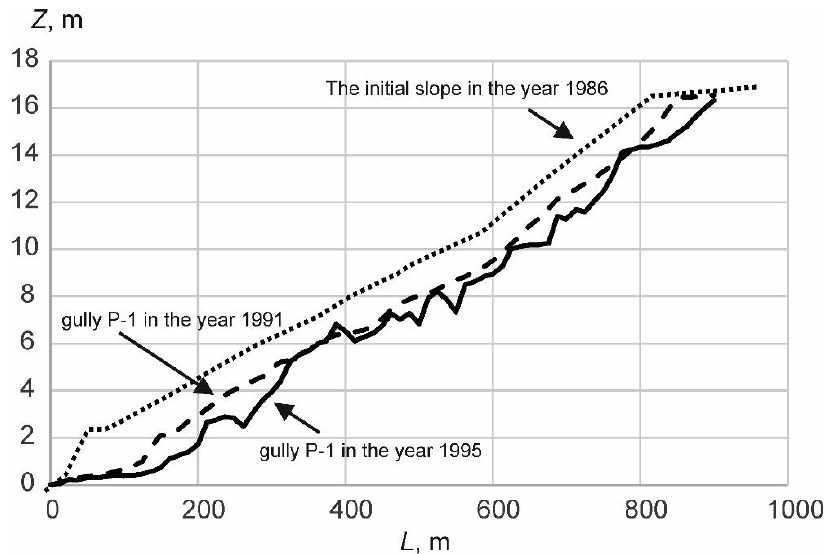
Figure 2. The longitudinal profiles of gully P-1, used for model calibration. Empirical coefficients and parameters, required to run GULTEM, were